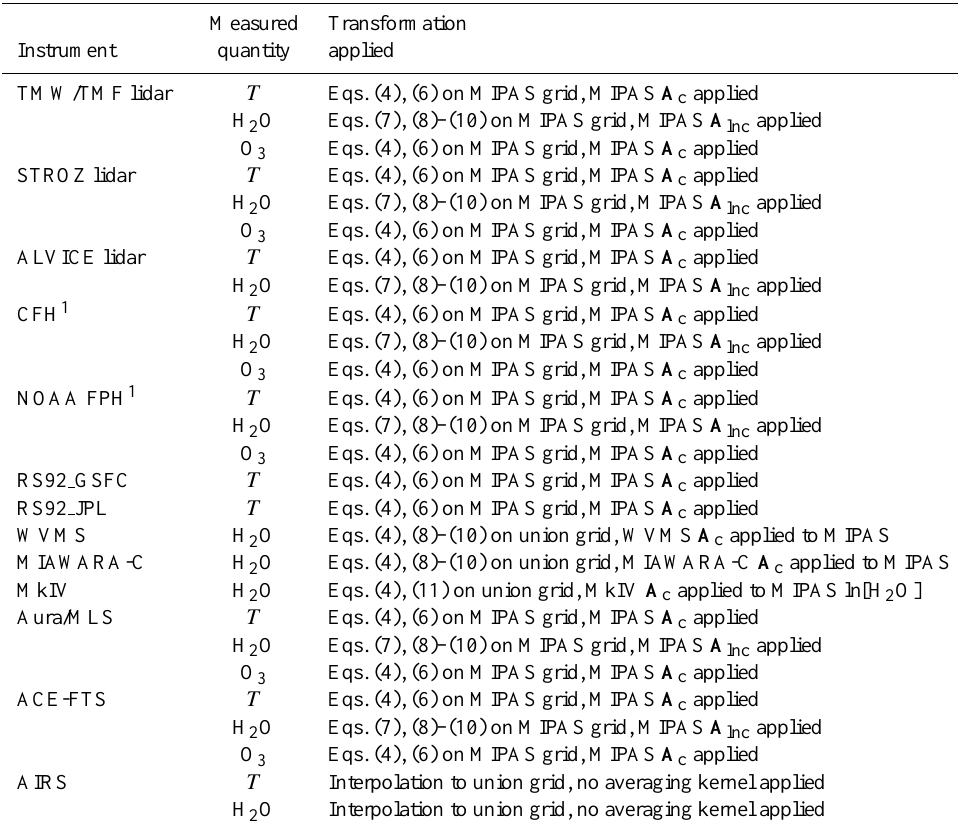
Interpolation to union grid, no averaging kernel applied H 2 O